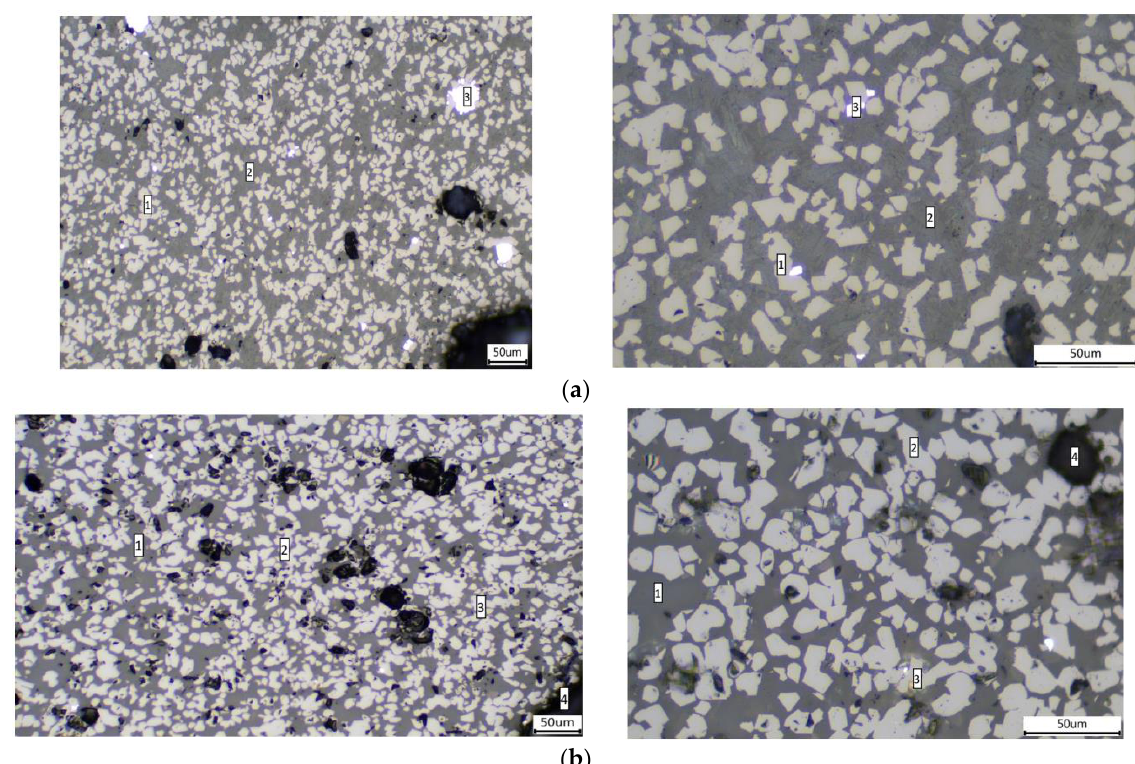
Figure 10. The mineral phase structure photos of vanadium slag before and after process optimi-